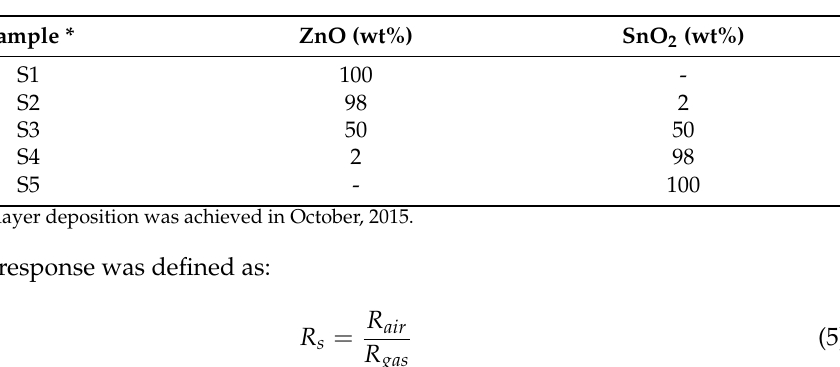
Table 4. The list of composite SnO 2 -ZnO based sensors and their composition obtained by sol-gel/dip coating method, after final thermal treatment (350 ◦ C, for 1 h), from Ref. [126].